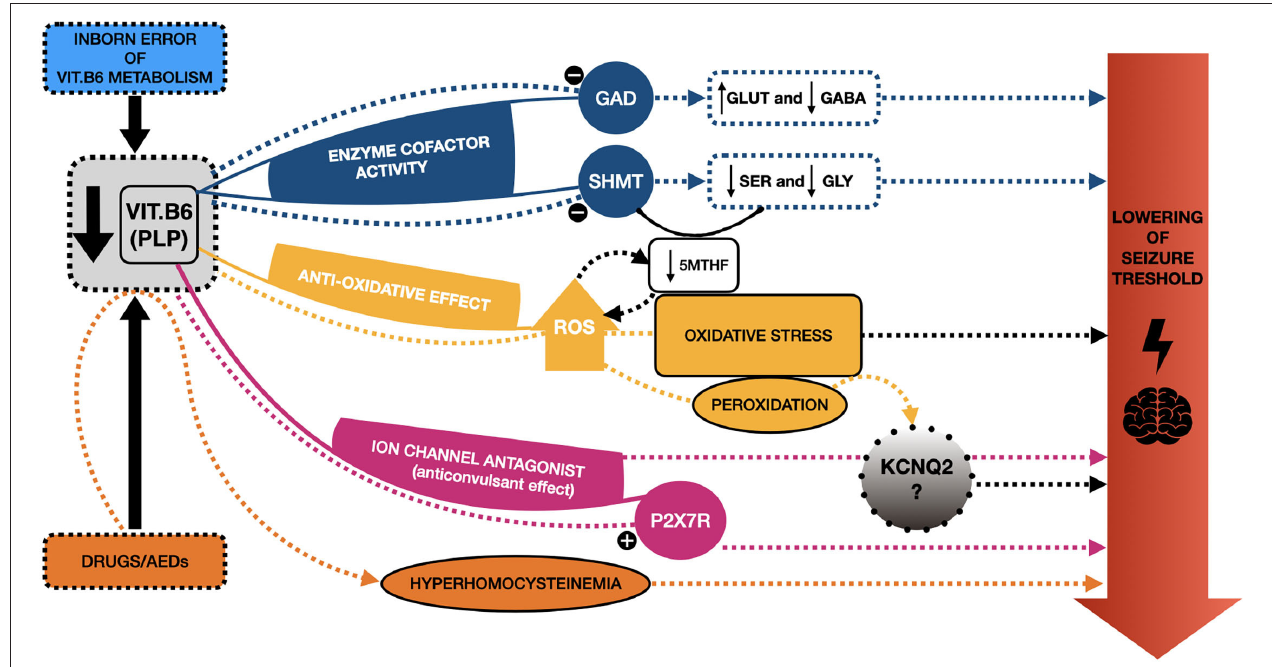
FIGURE 2 | Schematic representation of the mechanisms proposed to explain seizure responsiveness to vitamin B6 and the potential link with KCNQ2. Several etiopathogenic mechanisms have been proposed to explain the responsiveness of certain neonatal seizures to vitamin B6 (VitB6), and particularly to its active form, pyridoxal 5 ′ phosphate (PLP). PLP acts as a cofactor of several enzymes, such as Glutamic acid decarboxylase (GAD), regulating the synthesis of gamma-amino butyric acid (GABA) from Glutamate (GLUT). A reduction of PLP may determine an imbalance between these two (in favor of GLUT), hence decreasing the seizure threshold. PLP is also involved in the synthesis of serine (SER) and glycine (GLY), modulating the serine hydroxymethyltransferase (SHMT) activity; thus, a reduction of PLP may determine lower levels of these two amino-acids, whose reduction has been related to epileptic phenotypes. SHMT is involved in the metabolic pathway, eventually leading to the formation of the main circulating form of folates, the 5-methyltetrahydrofolate (5-mTHF), a reduction of which has been reported in some patients suffering from pyridoxine-dependent epilepsies (PDE). Furthermore, the reduction of 5-mTHF may fall into another proposed mechanism underlying epilepsy, namely oxidative stress, with excessive production of reactive oxygen species (ROS). This may be a consequence of low levels of VitB6 (anti-oxidative agent) and, at the same time, a cause of folates depletion. Additionally, ROS contribute to the peroxidation of several molecules, also affecting ion channels, hence potentially KCNQ2. PLP also acts as an antagonist of specific ion channels, as P2X7R, with a possible anticonvulsant effect, which could not occur when PLP levels are low. A similar antagonist action on KCNQ2, with possible analogous effects, has been proposed. Finally, some drugs, especially antiepileptic ones (AEDs), may